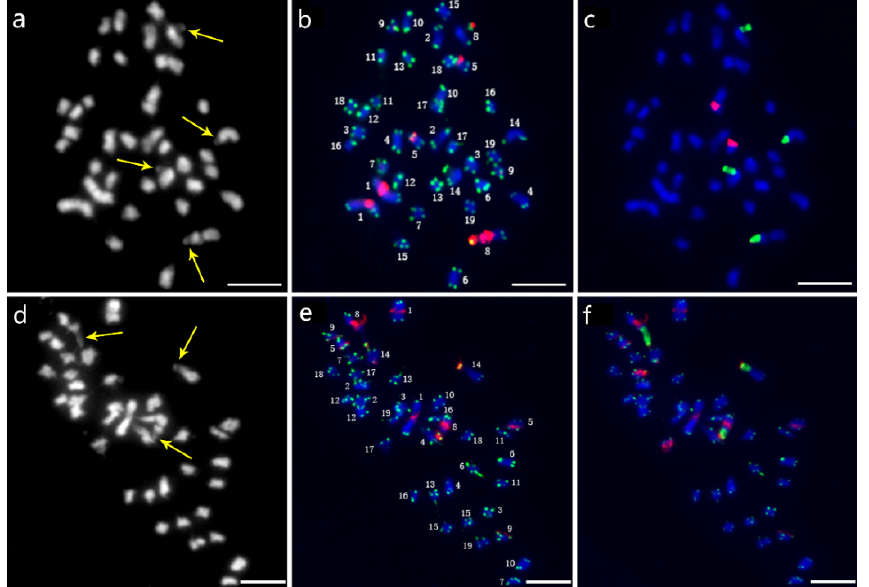
Figure 3. Sequential FISH patterns of P. xiaohei (upper panel) and the derived doubled haploid (lower panel). ( a , d ) Chromosome complements by DAPI staining; ( b , e ) FISH patterns probed with telomere sequences (green) and pPD284_XHY (red); ( c , f ) FISH patterns probed with 45S rDNA (green) and 5S rDNA (red). Bars = 5 μ m.